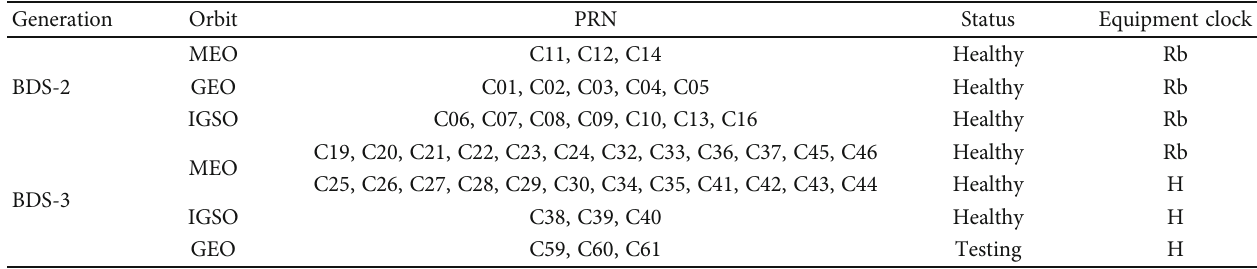
Table 2: The types and orbits of BDS on-board satellite clocks (the list of events as of October 2020) (http://www.igmas.org). Generation